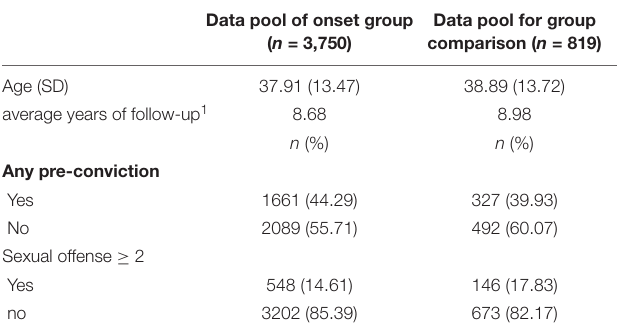
TABLE 1 | Demographic characteristics of the